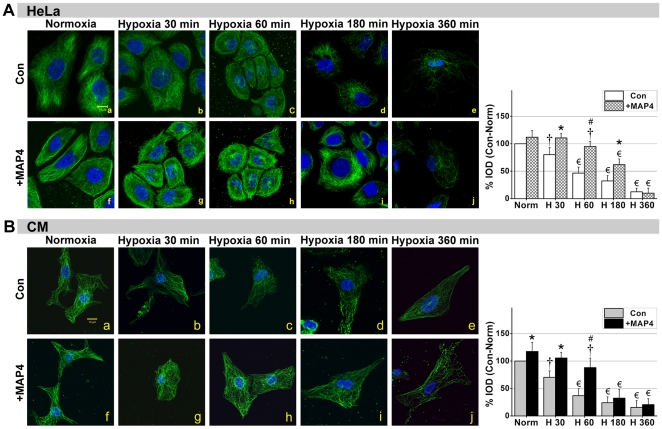
MAP4 overexpression alleviates MT disruption during the early stages of hypoxia.Immunofluorescent confocal micrographs of +MAP4 and Con (Non-transfected) HeLa cells (A) and CMs (B) under normoxia and hypoxia. Micrographs show the changes in MTs as hypoxia duration is increased. Graphs to the right represent the corresponding % Integral optical density of MTs (green) (IOD; values were normalized as percentage after comparison with normal, which were set to 100%; n = 3). Results show that the structure of MTs was significantly disrupted after 30 min of hypoxia in Con groups, while in +MAP4 groups this disruption was less apparent until 60 min. +MAP4 cells seemed to contain more MTs than Con cells undergoing the same level of hypoxia, especially at the earlier time points (≤60 min in CMs; ≤180 min in HeLa cells). All values are mean±SEM. * P<0.05, # P<0.01, vs. Con at each time point, Student's t test analysis; † P<0.05, € P<0.01, vs. Norm (Normoxia) within each group, One-way ANOVA followed by Tukey's post-hoc tests. Scale bar, 10 µm.